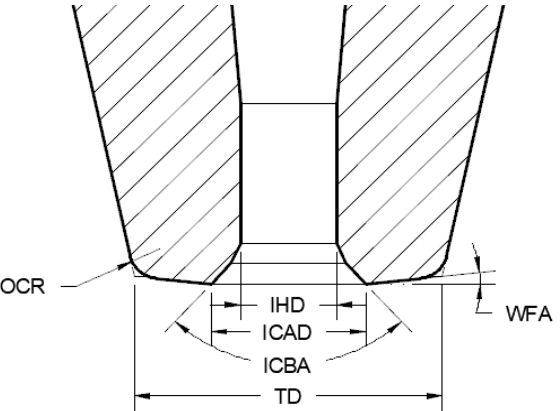
Figure 1. The main parameters of the ceramic capillary: IHD; ICAD; ICBA; TD; WFA; OCR [21].